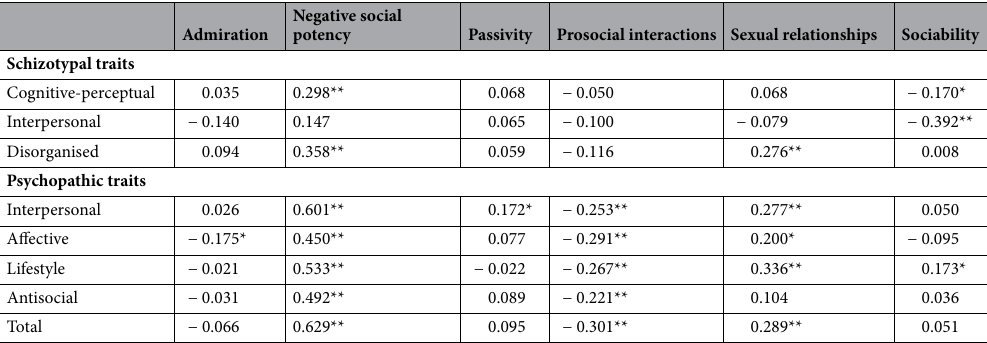
Table 1. Correlations between SRQ scores and schizotypy and psychopathy dimensions. *Significant at p = 0.05; **Significant at p = 0.01; all values r s